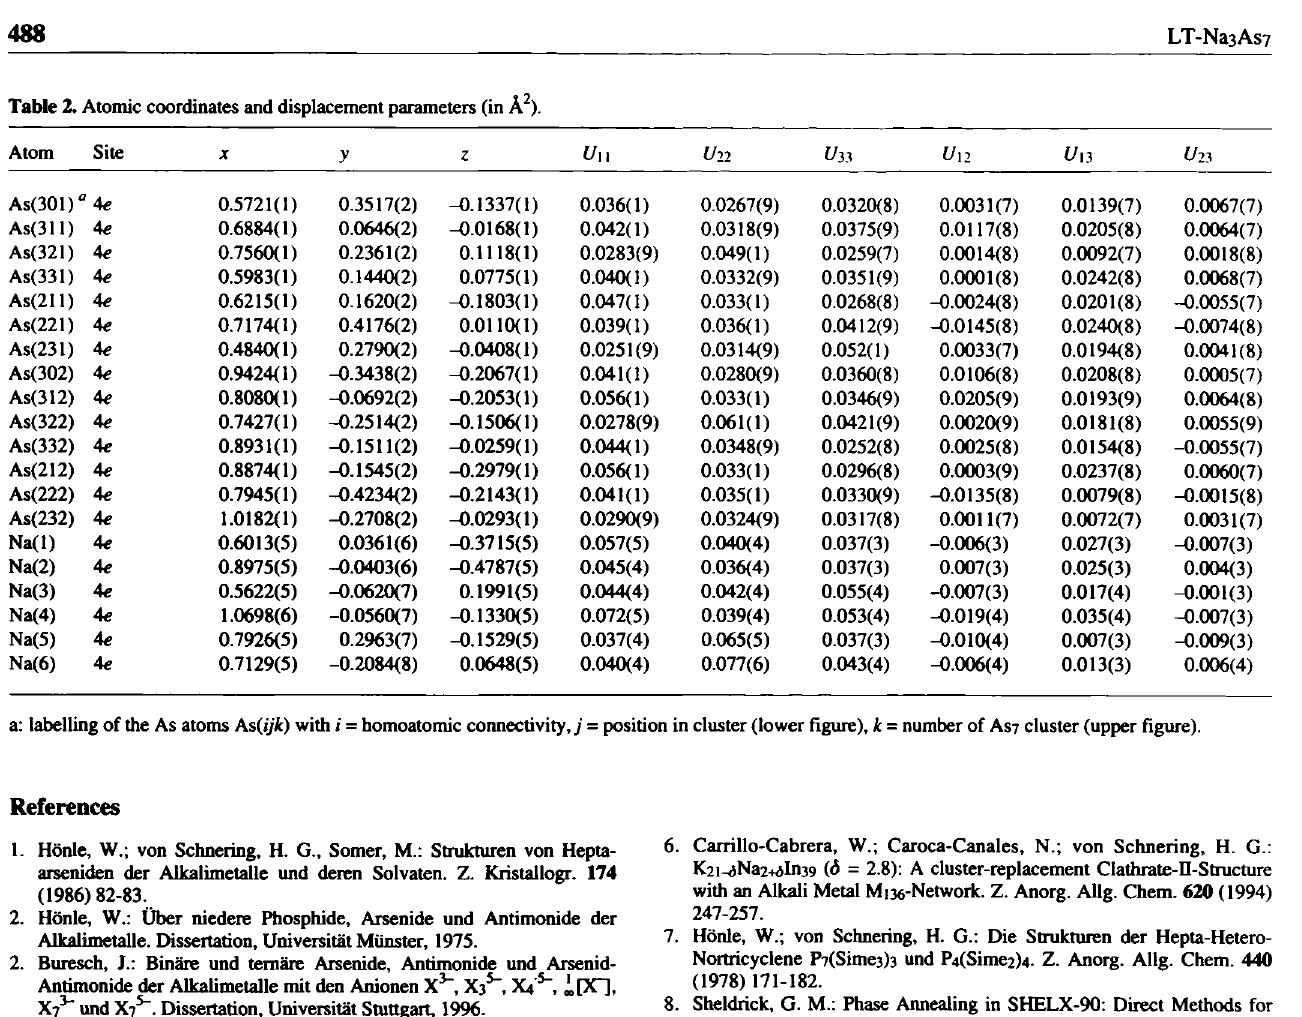
Table 2. Atomic coordinates and displacement parameters (in Â 2